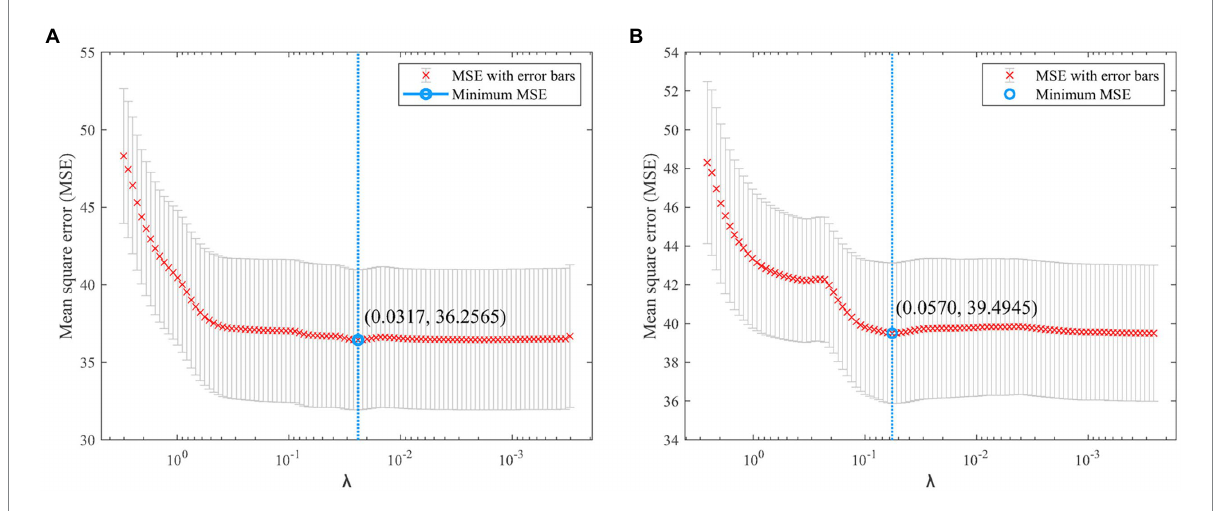
FIGURE 4 λ -value iterative process of Lasso algorithm with error bar. (A) RGB-based Lasso. (B) MS-based Lasso.